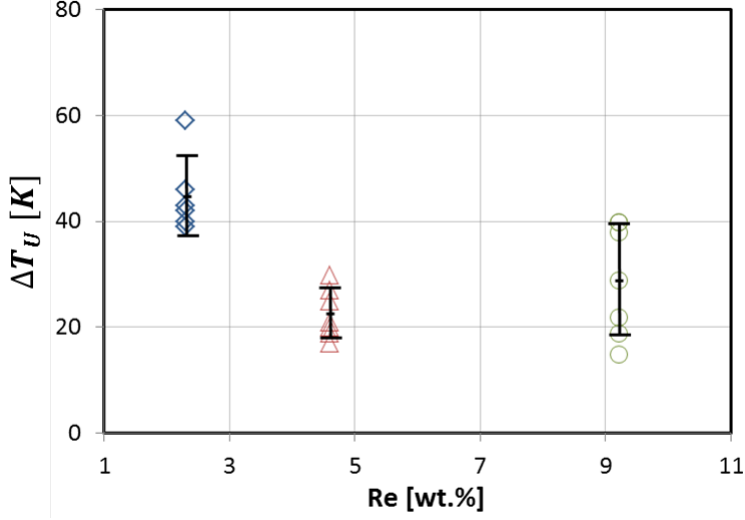
Figure 9. Critical undercooling Δ T U of the binary Ni-Re alloys.